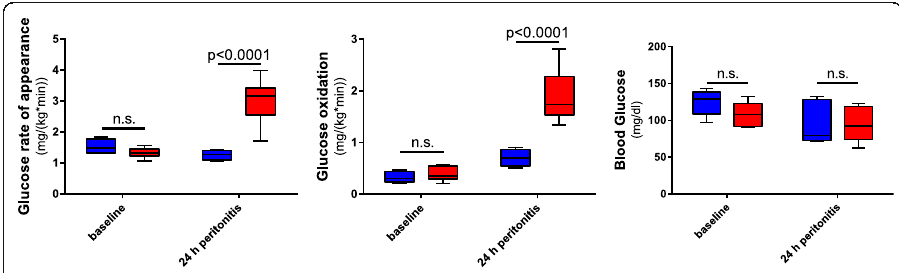
Fig. 1 Glucose metabolism. Glucose rate of appearance (sham n = 4, sepsis n = 7) (left panel) indicates endogenous glucose production. Aerobic whole-body glucose oxidation (sham n = 4, sepsis n = 5) (middle panel). Renal venous blood glucose levels (sham n = 5, sepsis n = 8) (right panel). Blue boxes, sham group; red boxes, sepsis group. n.s. p >